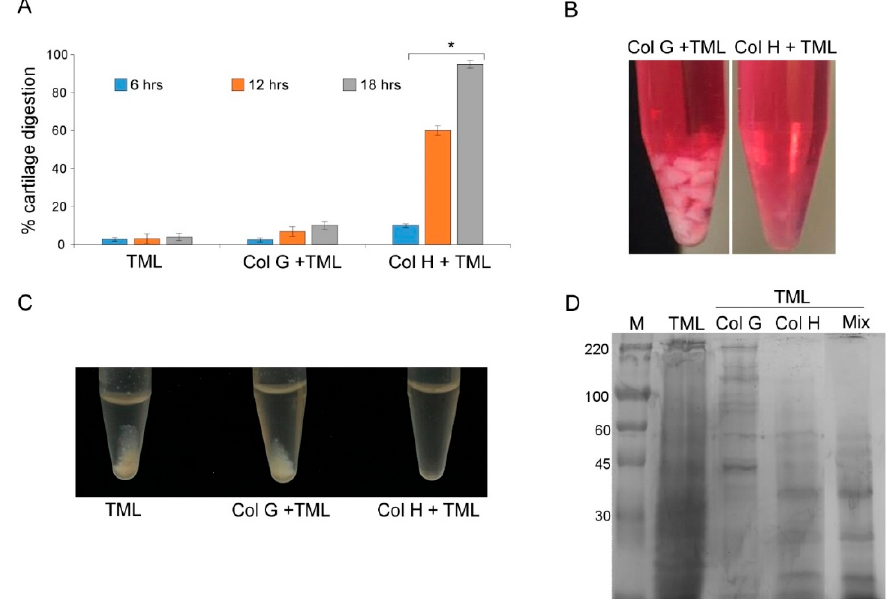
Figure 1. Performance of ColG and ColH in tissue disgregation. ( A ) Cartilage dissociation assay using ColG and ColH in the presence of TML at different times (6, 12, and 18 h). ( B ) Cartilage digested with Col H or G plus TML after 18 h of treatment. ( C ) Samples containing powered cartilage treated 24 h with only TML, ColG plus TML, or ColH plus TML. ( D ) SDS PAGE of protein extracted from cartilage digested with thermolysin (TLM) alone or added of ColG, ColH, or both ColG and H (Mix). M = High molecular weight marker. The data represent the mean ± SD of three independent experiments.